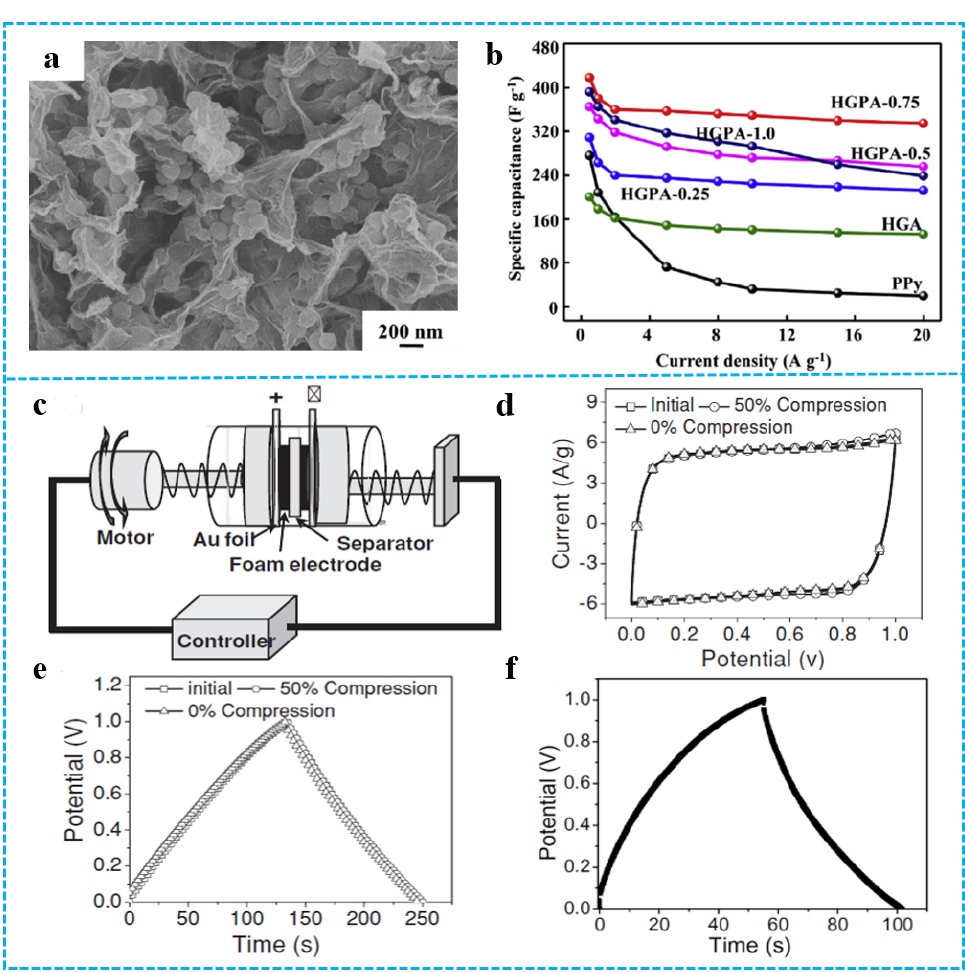
Figure 13. ( a ) The SEM image of HGPA-0.75. ( b ) Capacitive performances of various electrodes in 1.0 M KOH electrolyte: capacitance retention at different current densities. Reproduced with per- mission from [121]. ( c ) Schematic illustration of PPy − G − based supercapacitor devices. ( d ) CVs of the compressible supercapacitor cells based on PPy − G foam electrodes under 0% and 50% compression for one cycle. The scan rate is 30 mV/s. ( e ) The corresponding galvanostatic charge − discharge curves at a current of 1.5 A g − 1 under 0% and 50% compression. ( f ) The galvanostatic charge − discharge curves of two − electrode 3D graphene supercapacitor at a current of 1.5 A/g. Reproduced with per- mission from [41].